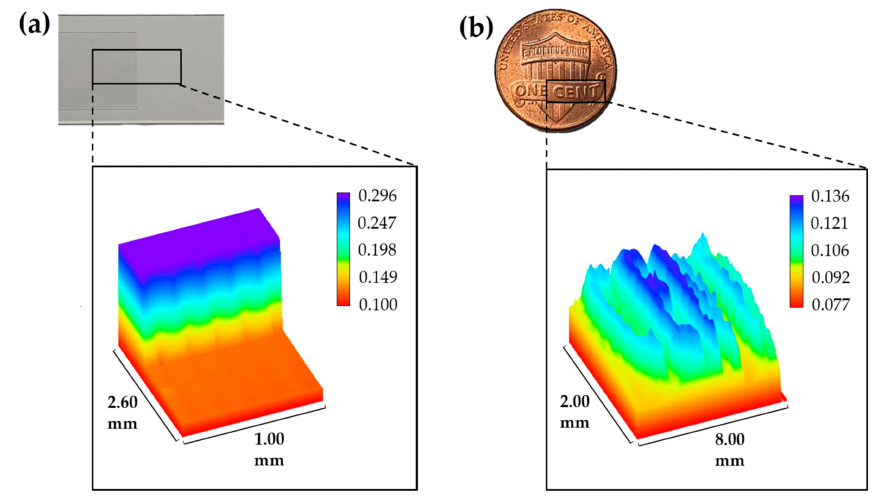
Figure 5. Three-dimensional (3D) surface profile images of ( a ) a cover glass stacked on a glass slide and ( b ) a “US cent” coin measured using the SS-CCM